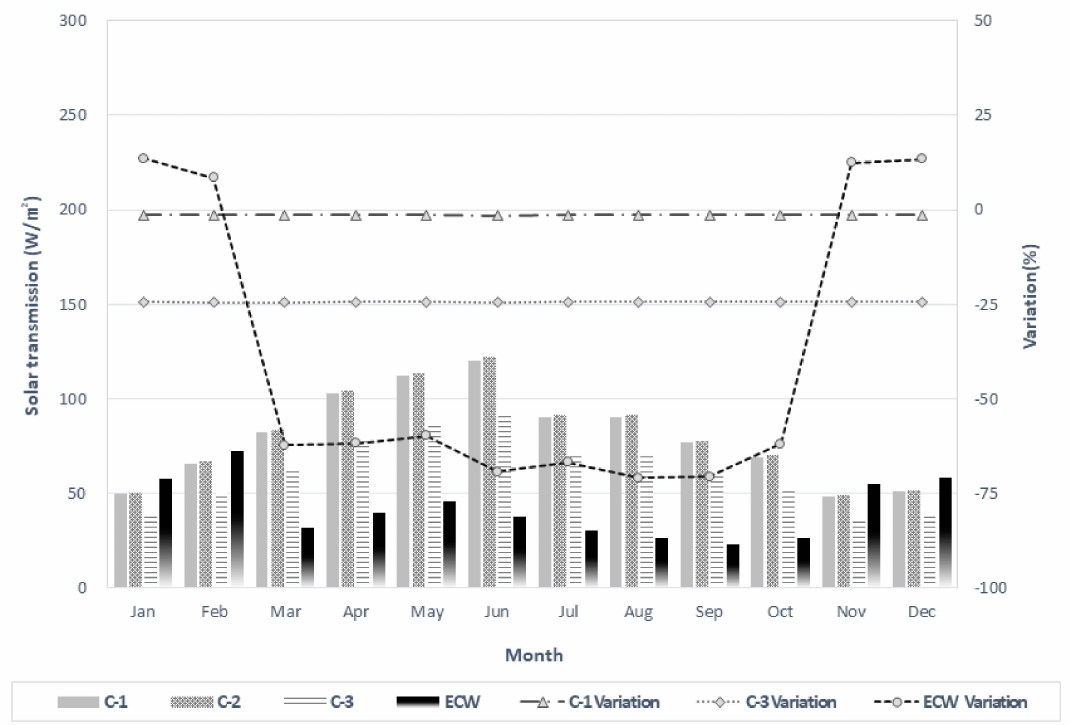
Figure 6. Solar transmission performance by direction (Monthly)—North.